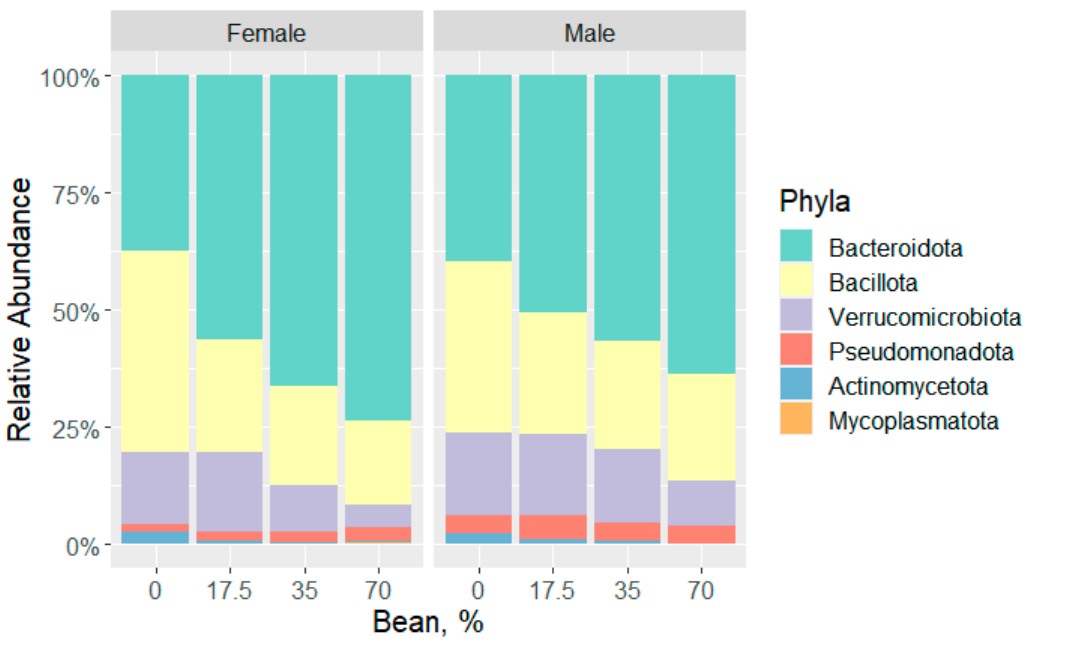
Figure 1. Relative abundance of identified phyla across the diet groups of each sex cohort.